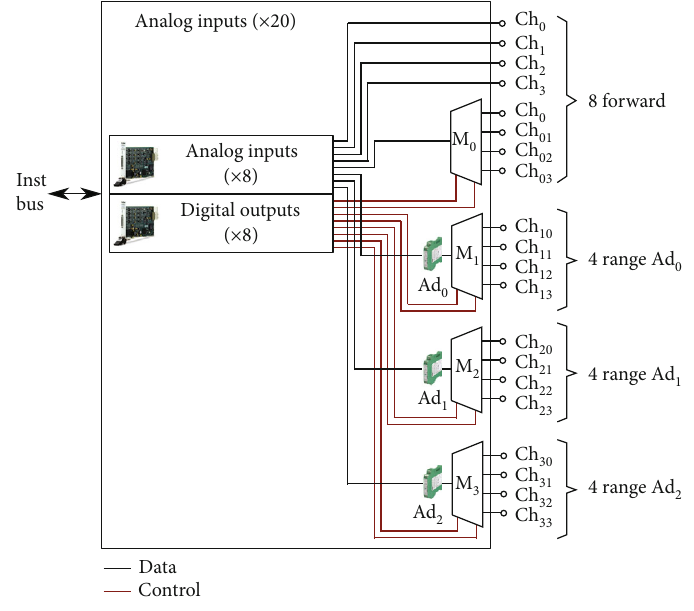
Figure 14: Example of